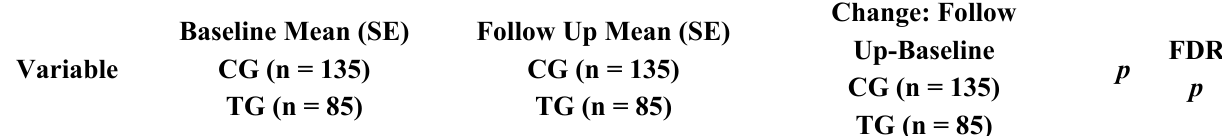
Table 3. Bone turnover markers pre- and